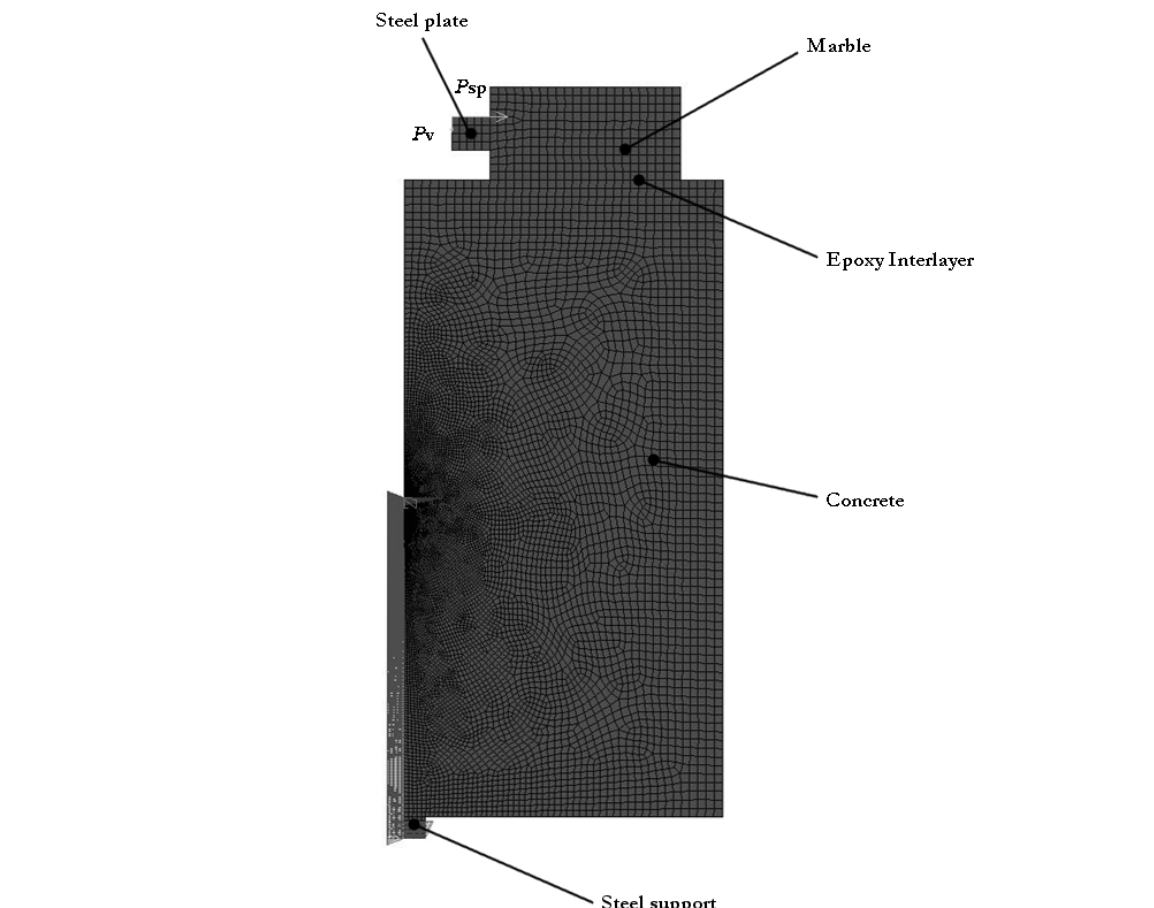
Figure 2: Numerical model of wedge splitting specimens with boundary conditions, symmetrical